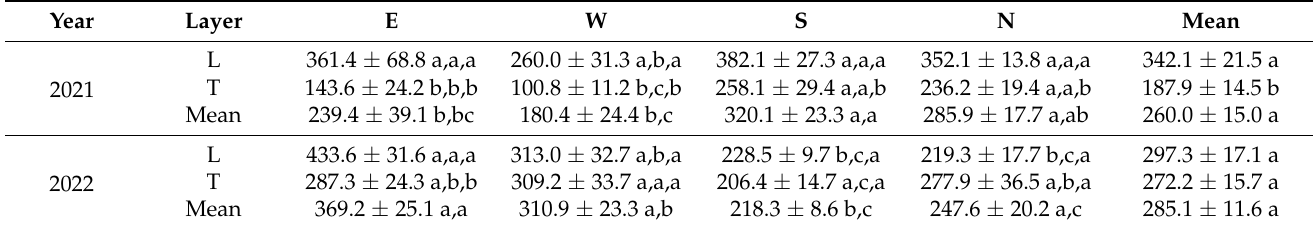
Table 3. Hulled fruit yield of almonds for each layer (g) in 2021 and 2022 in different expositions (E, W, S, N) for different layers: low (L; 0.5–1.4 m) and top (T; 1.4–2.3 m). The first letters denote statistical differences between years for an exposition and a layer; the second letters denote statistical differences among expositions for a year and a layer; the third letters denote statistical differences between layers for a year and an exposition ( p = 0.05; SNK test).